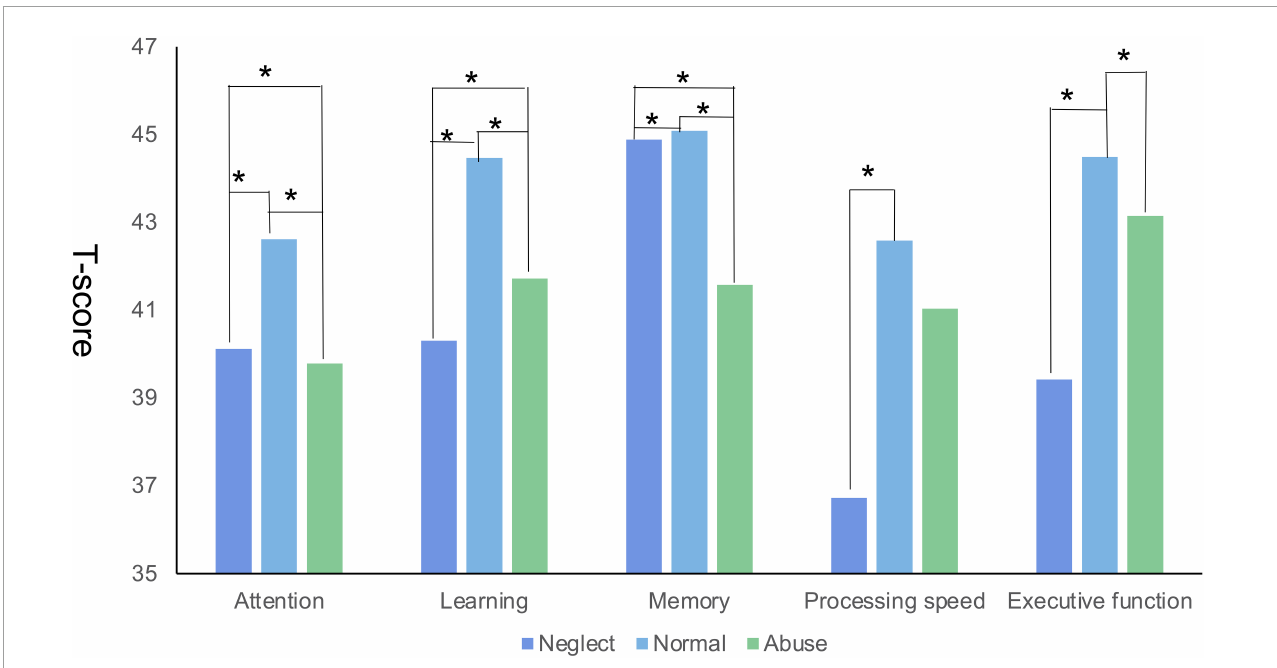
FIGURE4 The differences of the T-score in each cognitive domain among different latent classes (*represents P <